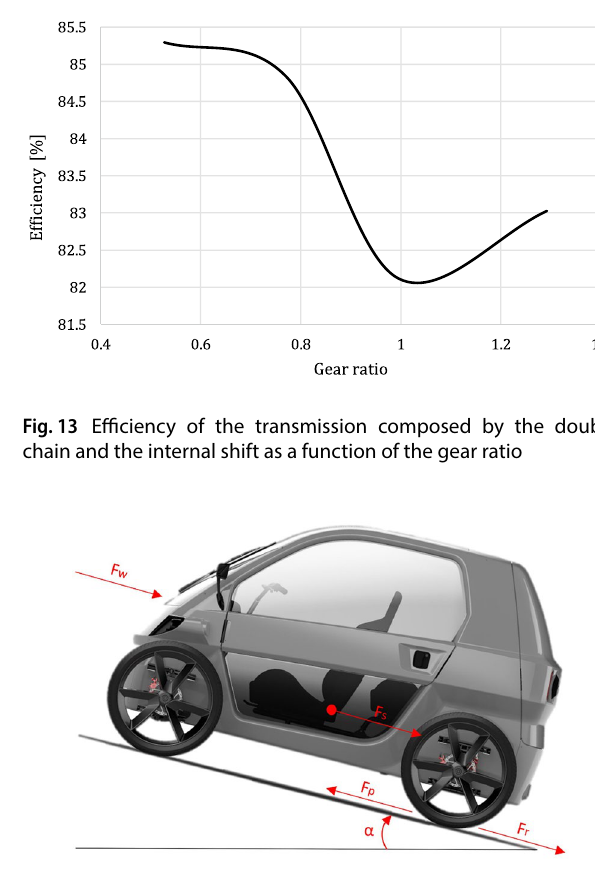
Fig. 14 Longitudinal dynamics for